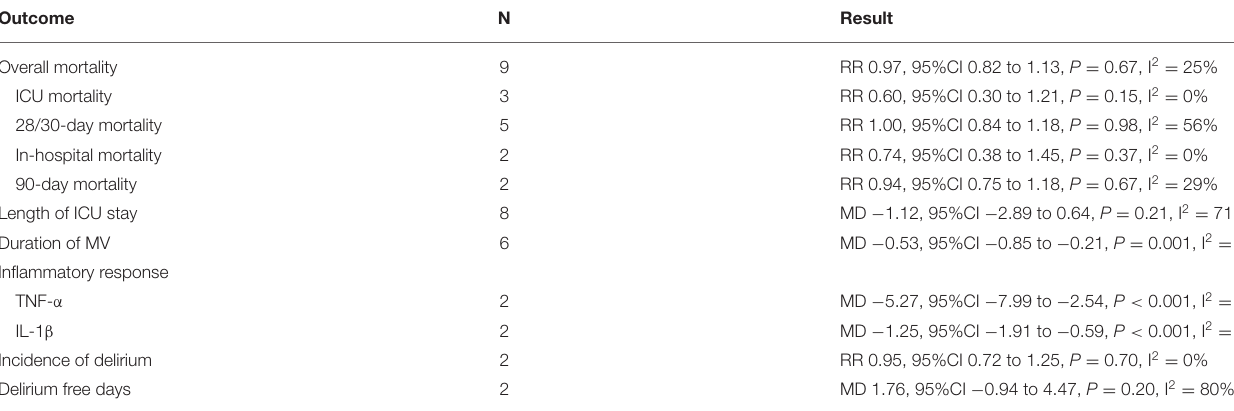
TABLE 2 | Primary and secondary outcomes of this meta-analysis.